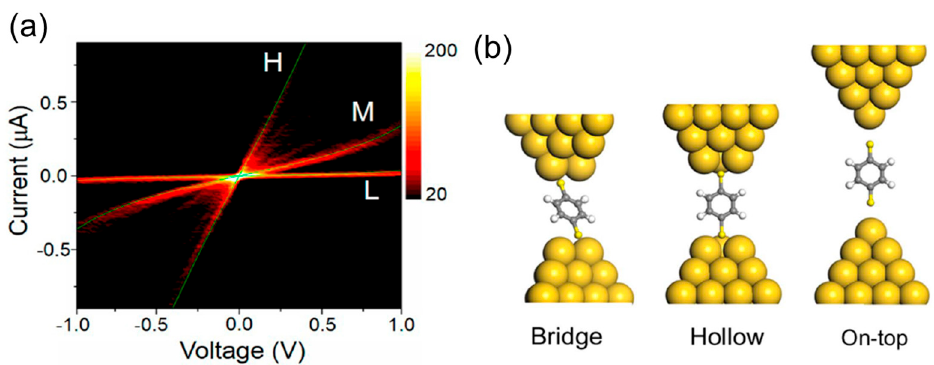
Figure 11. ( a ) Distribution of I – V curves of benzenedithiol (BDT) junctions constructed from 200 I – V curves. ( b ) Structural model of BDT single-molecule junctions. Bridge, hollow, on-top are assigned to H , M , and L states in I – V curves. Reproduced with permission from [40,53] copyright Science Report